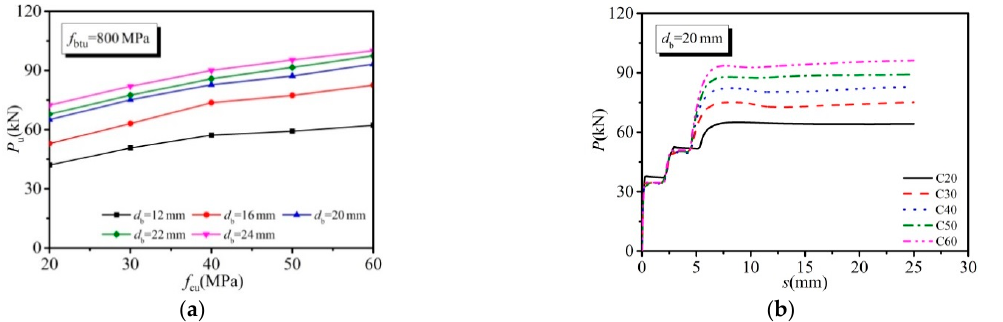
Figure 10. Effect of concrete strength: ( a ) shear bearing capacity; ( b ) load–slip relationship.